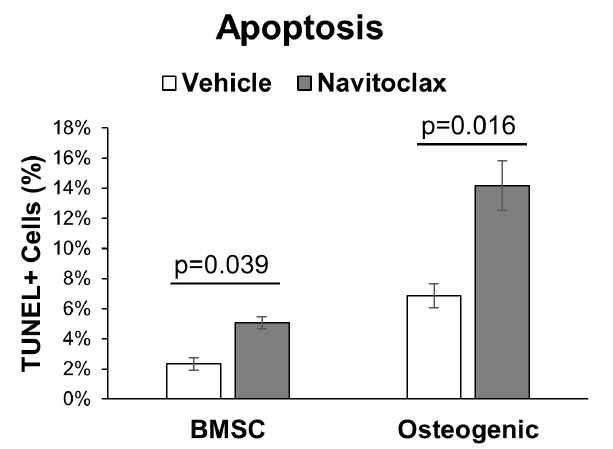
FIGURE 5 | Navitoclax promotes apoptosis in BMSC and osteogenic cultures. Primary BMSC from aged female wildtype mice (27 months old) were treated with navitoclax (5 µ M) or vehicle (DMSO) for 24 h in BMSC growth medium or osteogenic medium. Cells were stained with an in situ TUNEL detection kit to quantify apoptosis in the cultures; TUNEL+ cells were identified by green staining and normalized to total cell number. P -values shown represent pairwise comparisons between navitoclax (gray) and vehicle (white)-treated